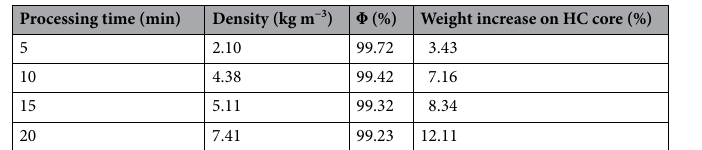
Processing time